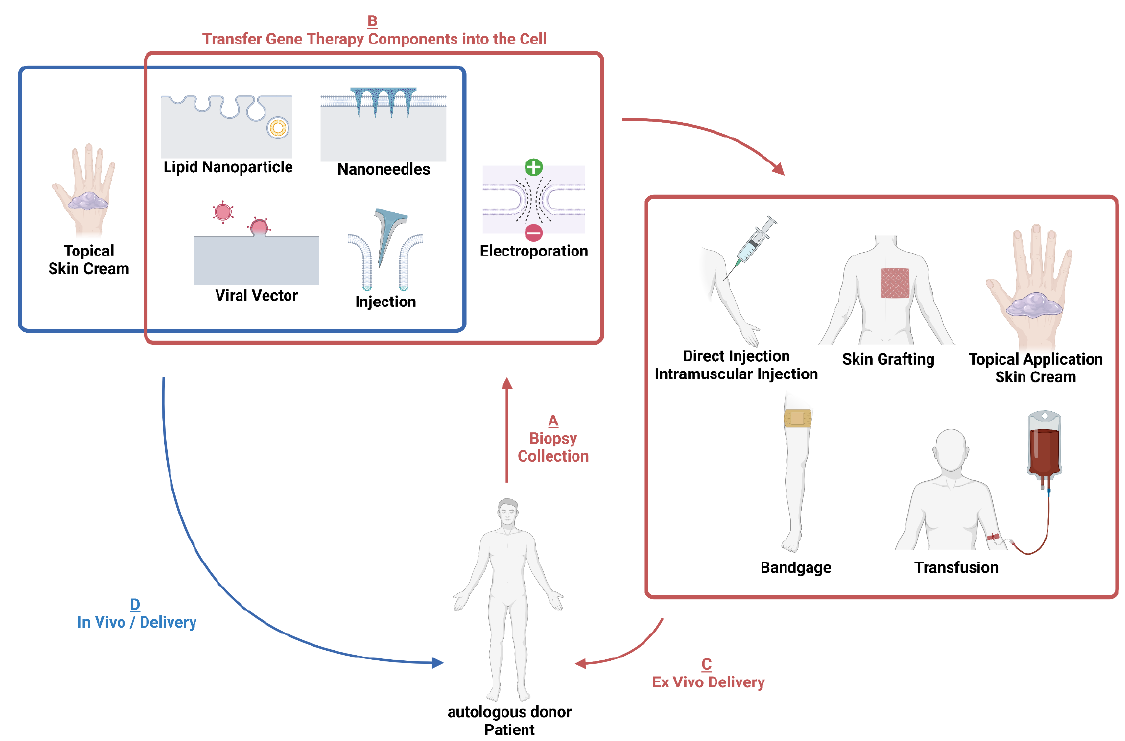
Figure 3. Graphic overview of ex vivo and in vivo delivery systems for therapeutic gene editing. Ex vivo delivery is highlighted in red on the right. A: biopsy is collected from patients and target cells are purified for cell culturing in vitro. B: gene editing tools are transferred into the cells to genetically modify the genome to restore normal function. C: the edited cells are then transferred back to the patients through different routes. In vivo delivery is highlighted in blue on the left. D: gene editing cargo is packed in delivery intermediates and then transferred to patients’ target tissue to finish editing. Created with BioRender.